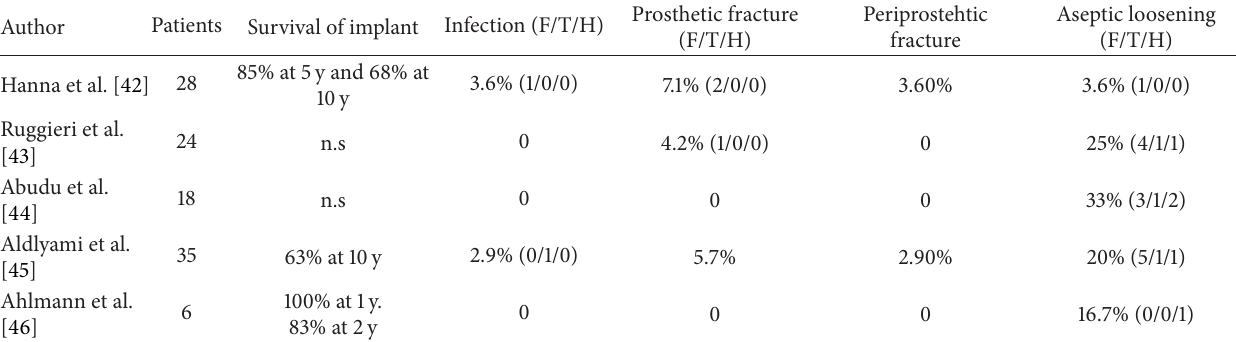
Table 3: Comparison of reconstructions with intercalary